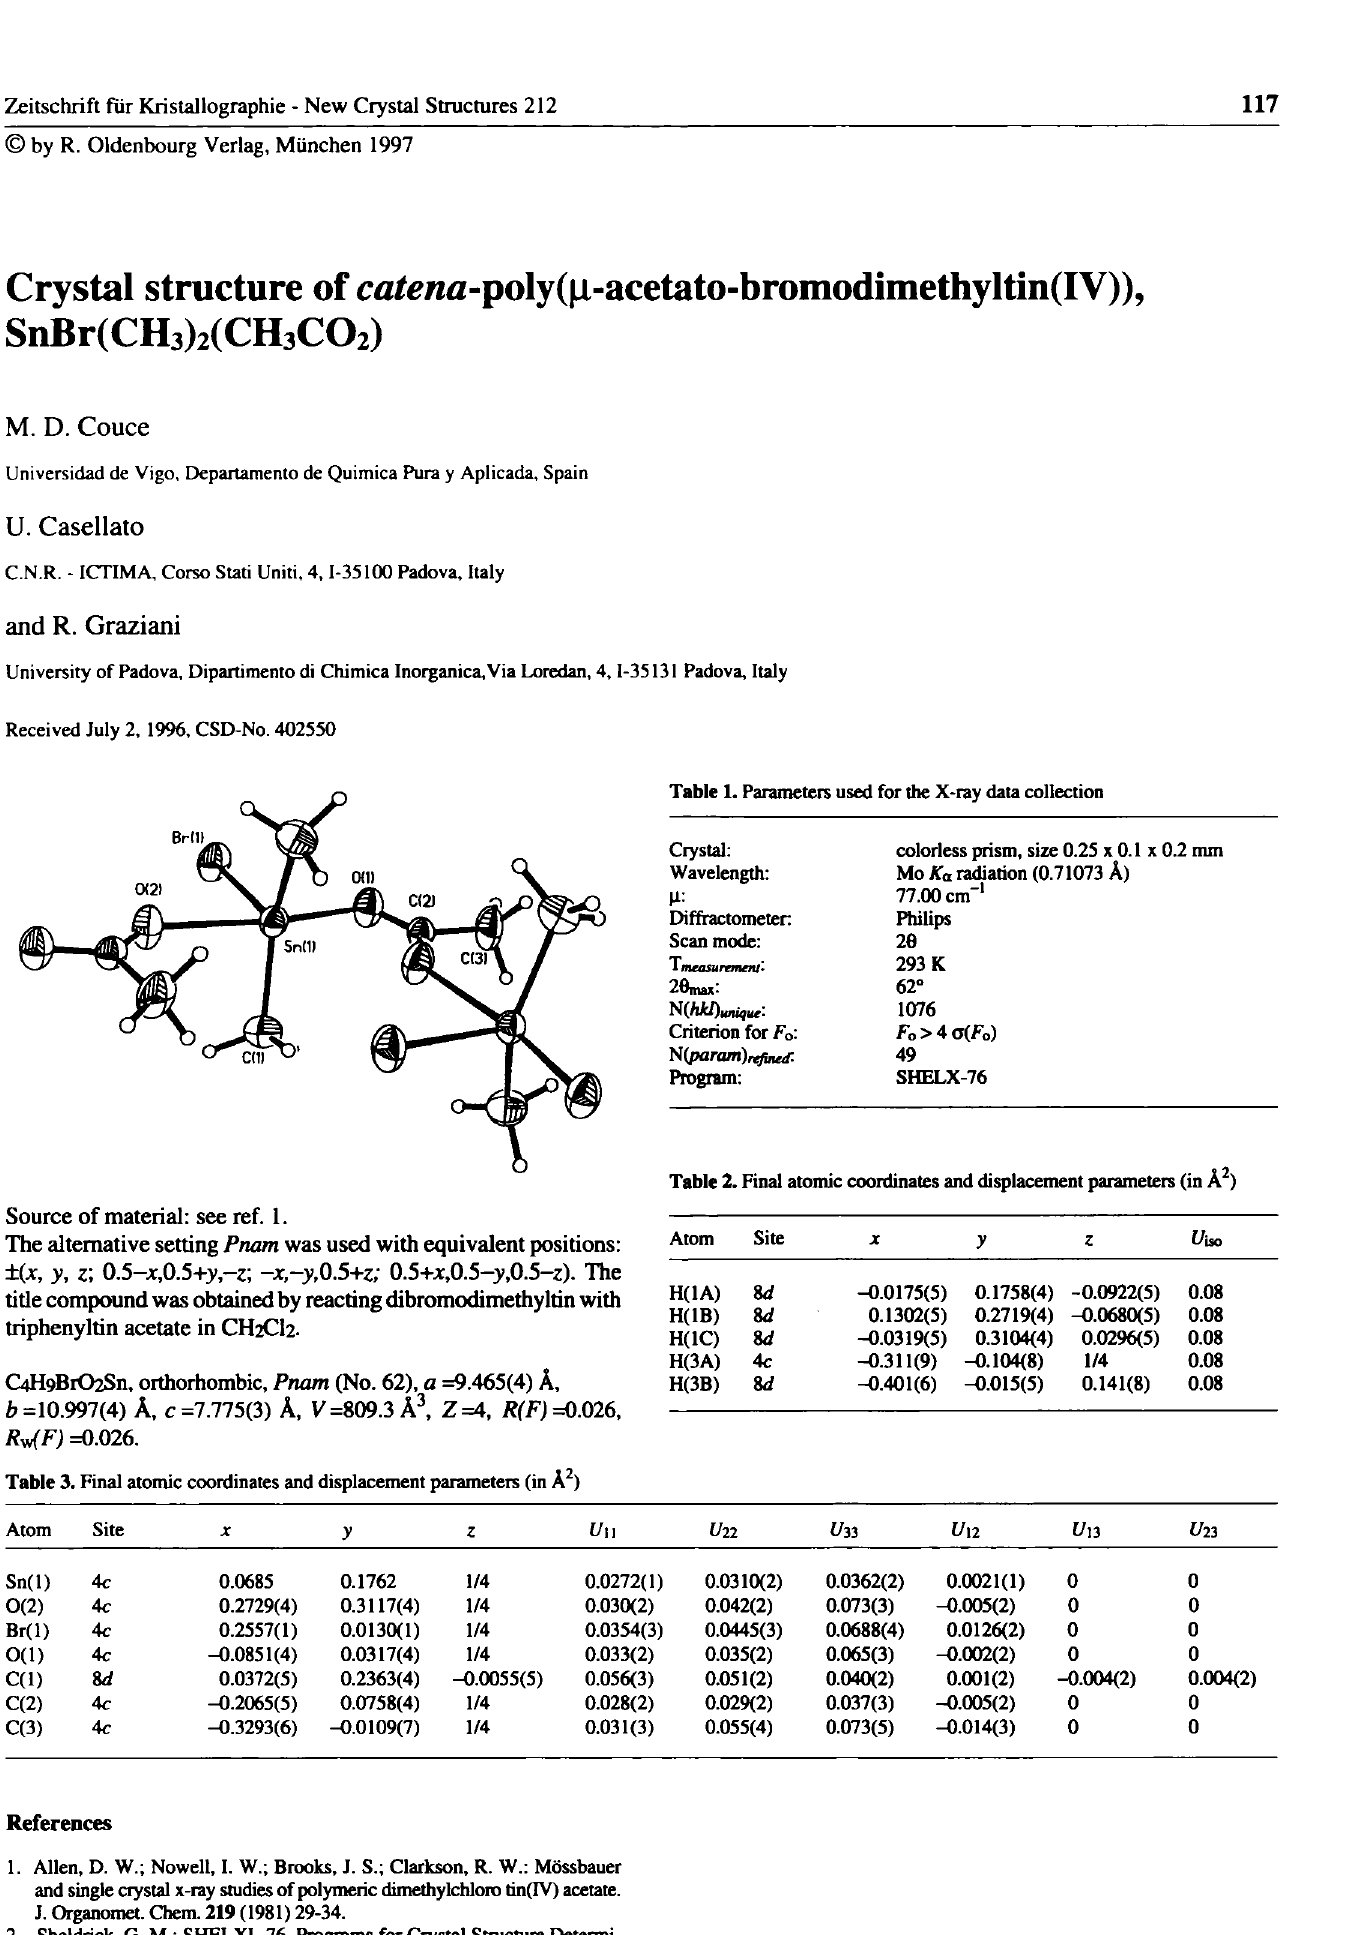
Table 3. Final atomic coordinates and displacement parameters (in A 2 )